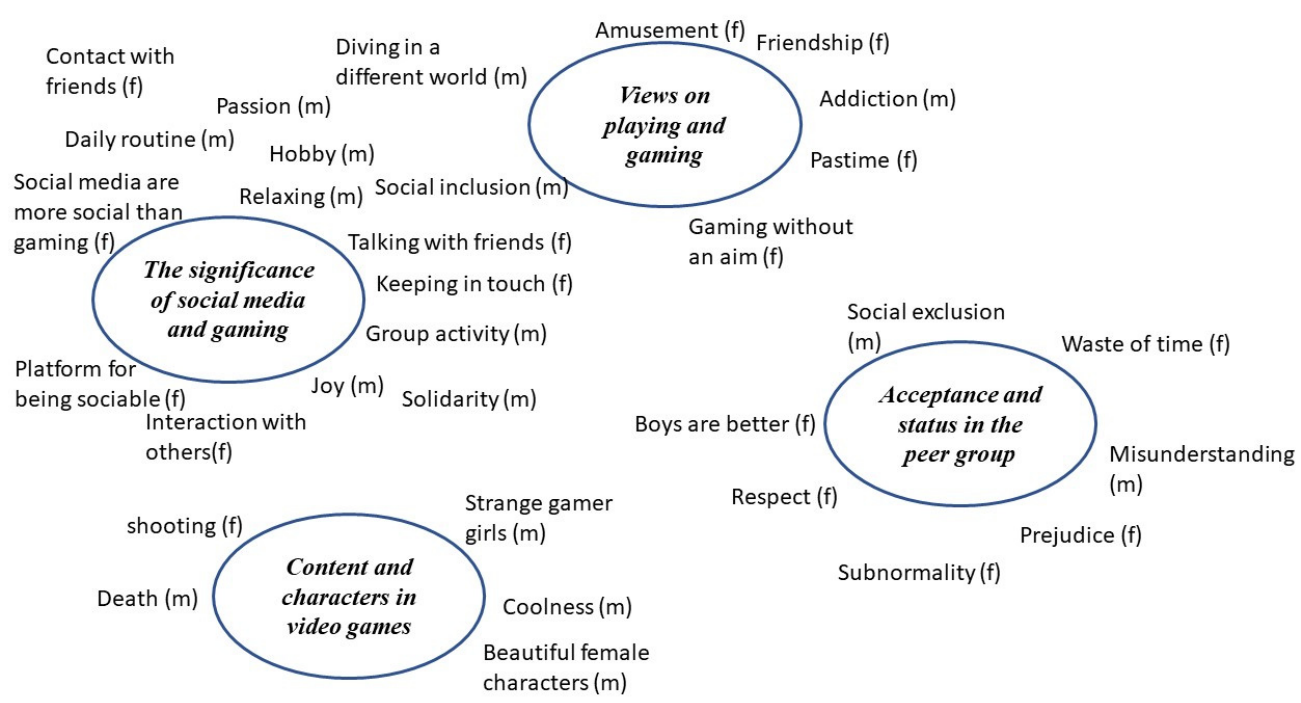
Figure 1. Themes generated by mind mapping. (m) = mentioned by male participants; (f) = mentioned by female partici- pants.